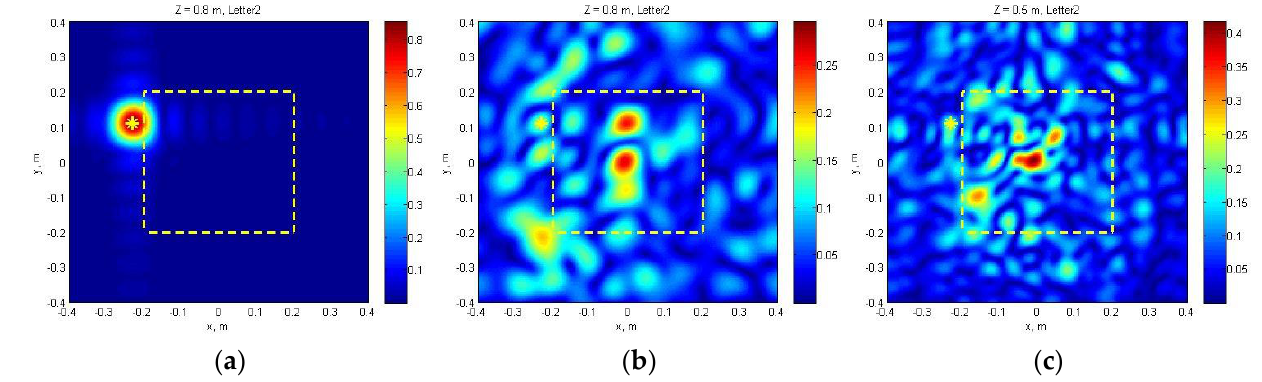
Figure 15. ( a ) Gaussian approximation of the specular image of the emitter; ( b ) cutting off the imaginary source; ( c ) migration into the object plane. Dotted line—HSR contour; asterisk—radiator position.